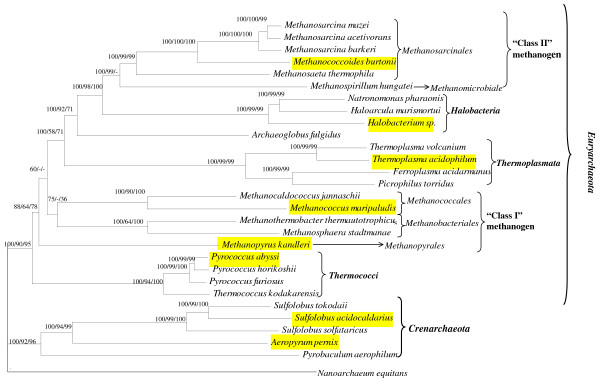
A neighbour-joining distance tree based on a concatenated sequence alignment for 31 widely distributed proteins. The numbers on the nodes indicate bootstrap scores observed in NJ/ML/MP analyses. The species shaded in yellow were selected as the query genomes for blast searches.